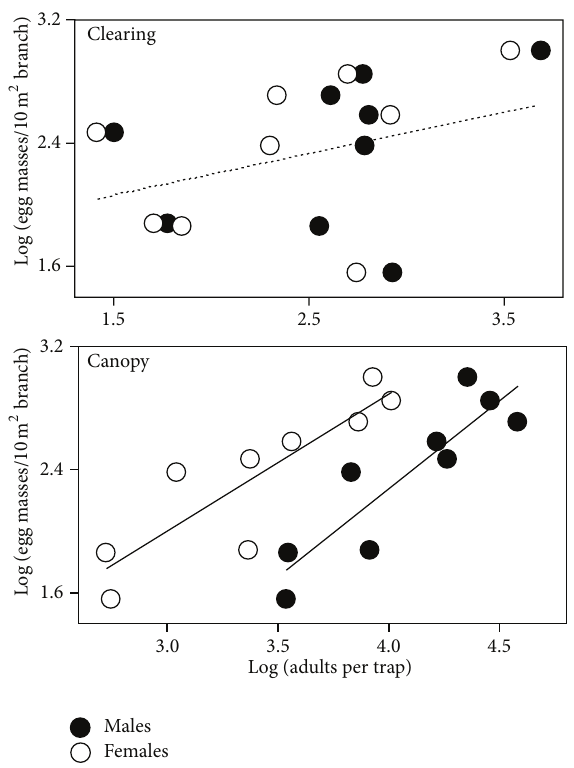
Figure 2: Relationships between numbers of adult spruce bud- worms captured at light traps deployed in tree canopies and forest clearings ( 𝑥 -axis) and the density of eggs ( 𝑦 -axis) at nine locations in New Brunswick, Canada, in the 1970s. Regressions based on captures in tree canopies were statistically significant for both males ( 𝑦 = 1.14𝑥 − 2.30 , 𝑟 2 = 0.796 , and 𝑃 = 0.0012 ) and females ( 𝑦 = 0.89𝑥 − 0.67 , 𝑟 2 = 0.776 , and 𝑃 = 0.0017 ) (solid lines). Regressionsbasedoncapturesinforestclearingswerenotsignificant for either sex (males: 𝑦 = 0.27𝑥 + 1.67 , 𝑟 2 = 0.119 , and 𝑃 = 0.3626 ; females: 𝑦 = 0.34𝑥 + 1.56 , 𝑟 2 = 0.205 , and 𝑃 = 0.221 ) (dotted lines). Data were subjected to logarithmic transformations to reduce heterogeneity of